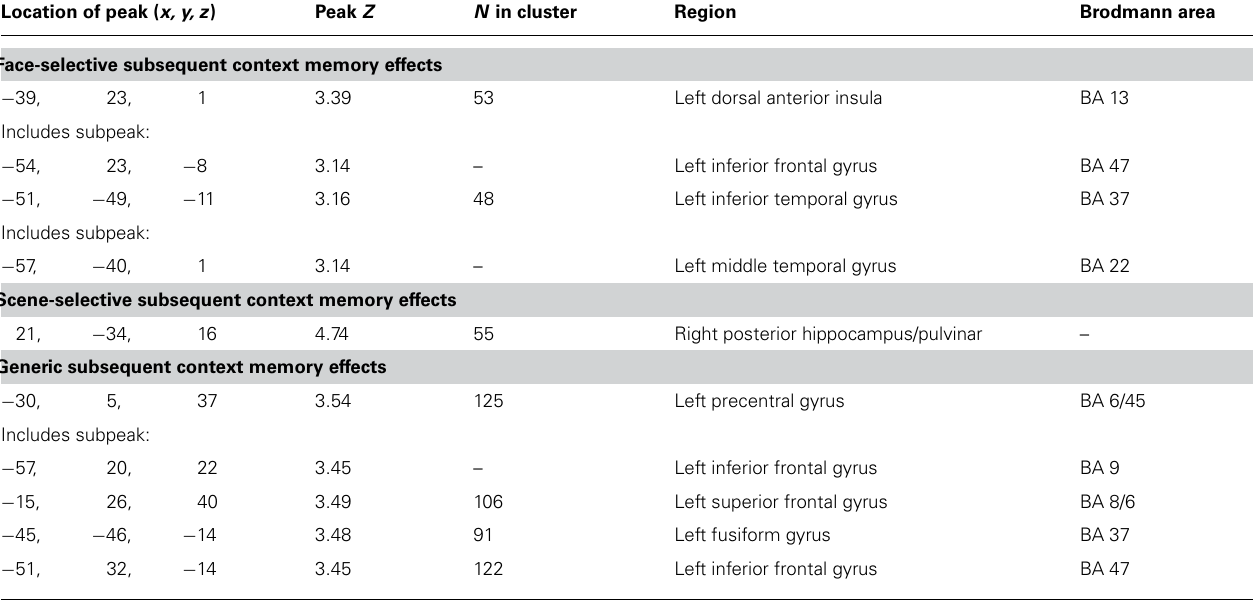
Table 1 | Encoding success: selective and generic contextual encoding effects. Location of peak ( x, y, z